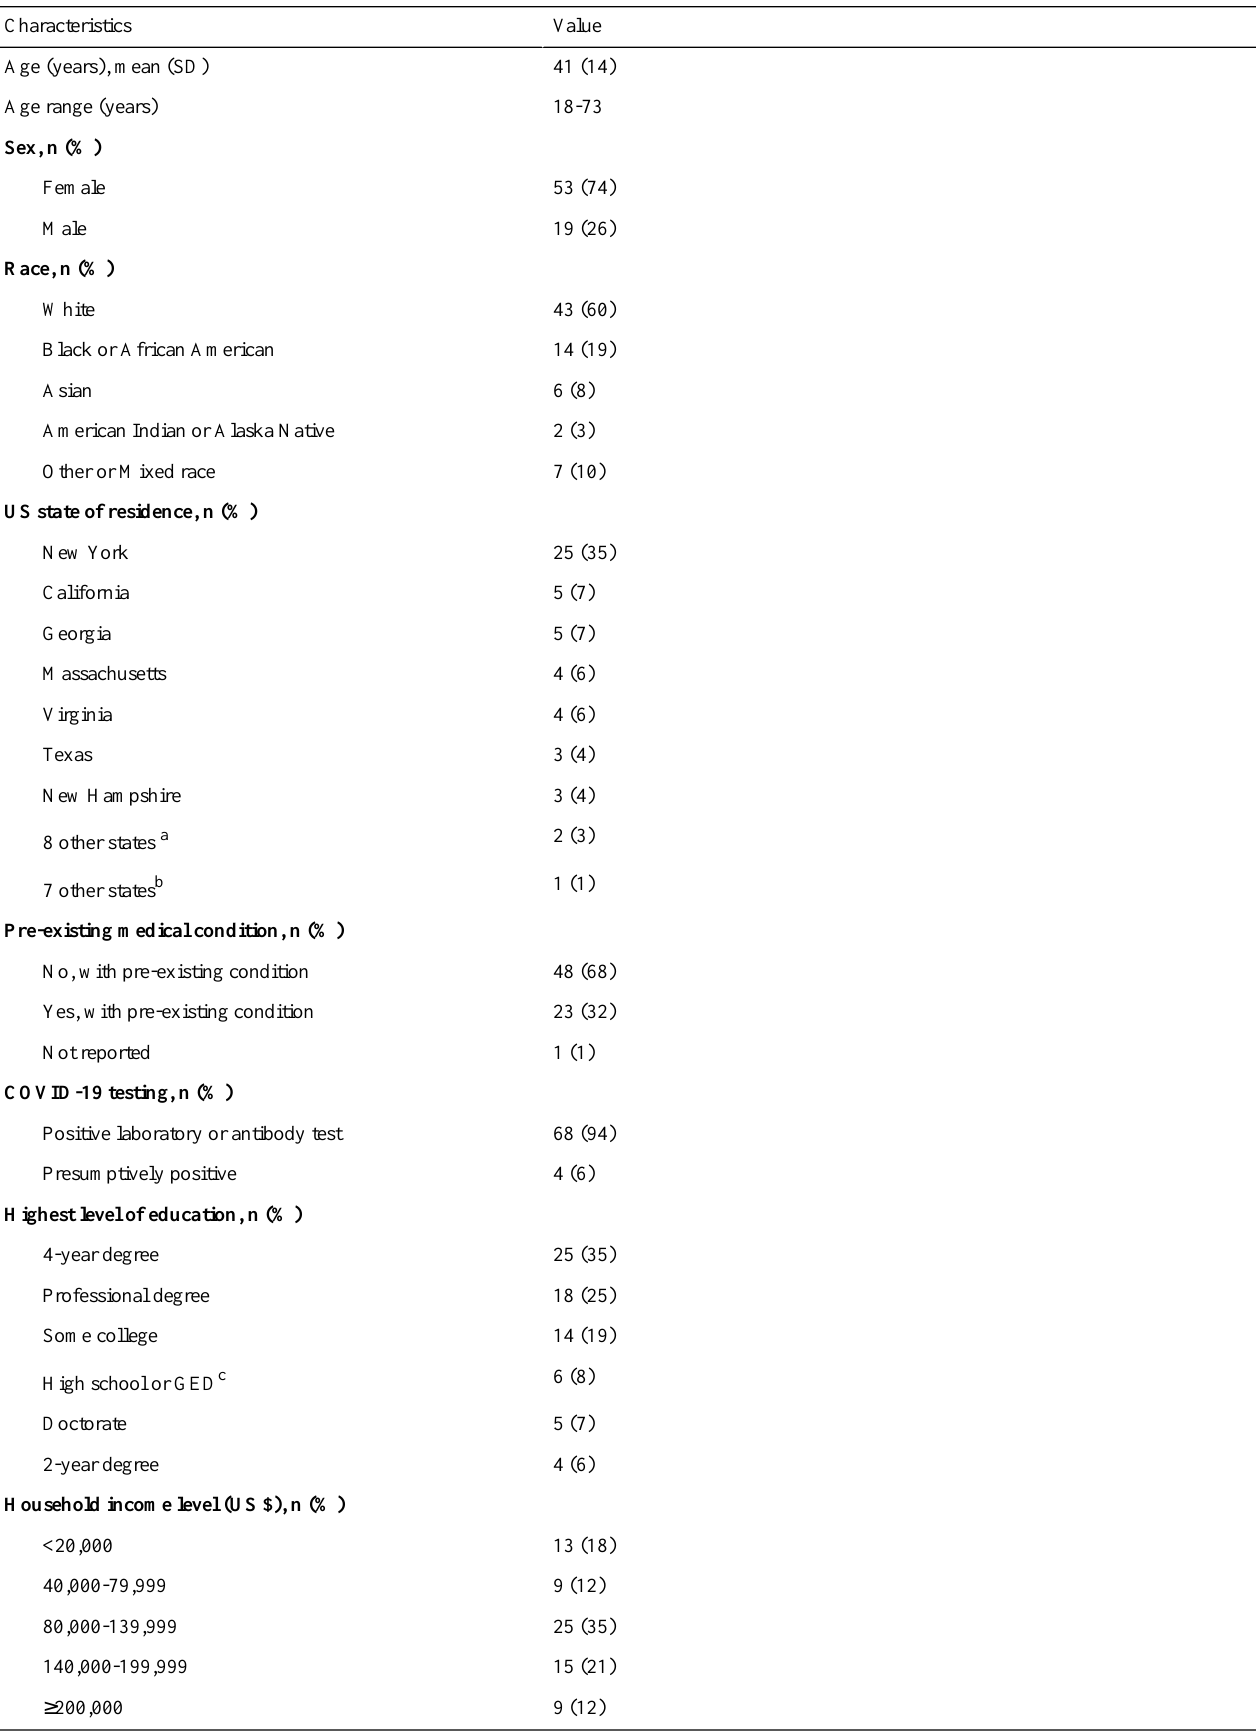
Table 1. Demographic summary of participants (ie, COVID-19 survivors) in the C19 Insider Scoop Study